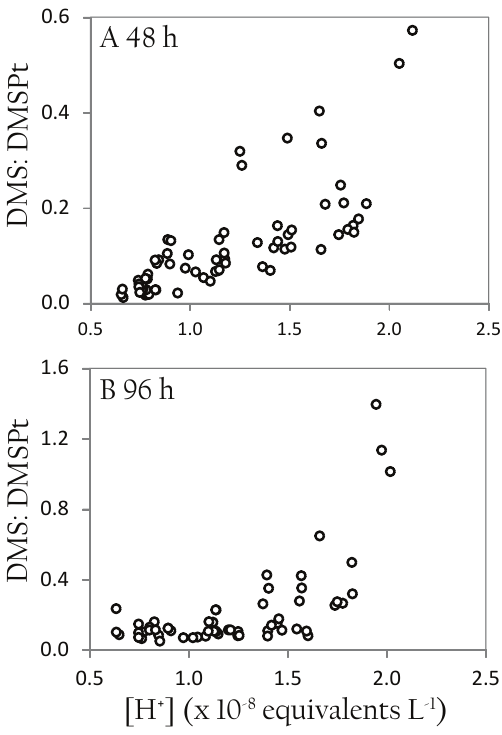
Figure 3. Relationship between DMS:DMSPt and H + concentra- tion, ([H + ] × 10 − 8 equivalents L − 1 ) at 48h (a) and 96h (b) for all data from all five bioassay